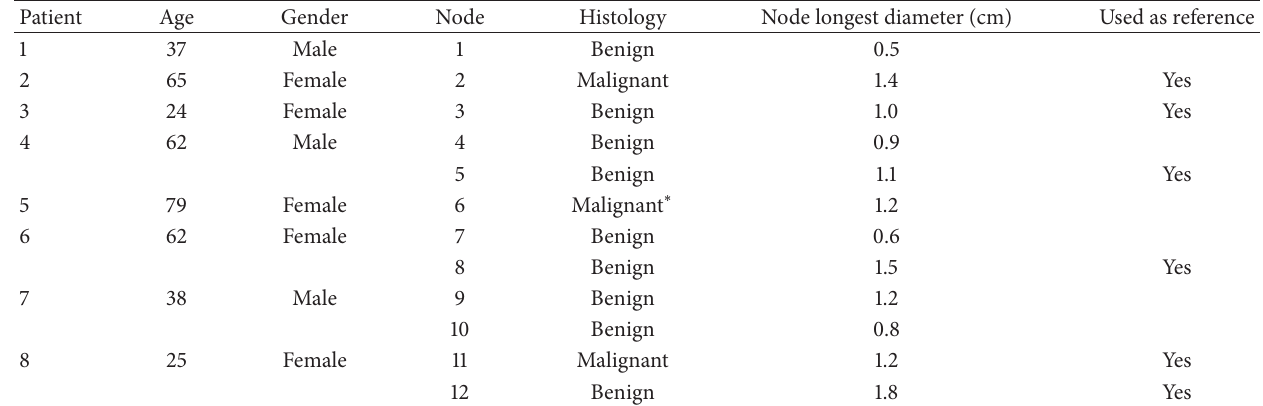
Table 1: Patient characteristics.